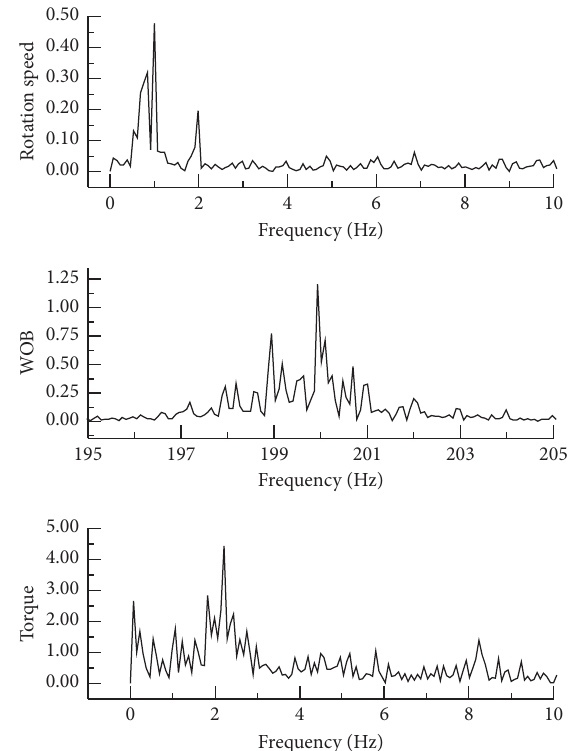
Figure 6: Frequency spectrum of WOB, rotation speed, and torque under axial impact.